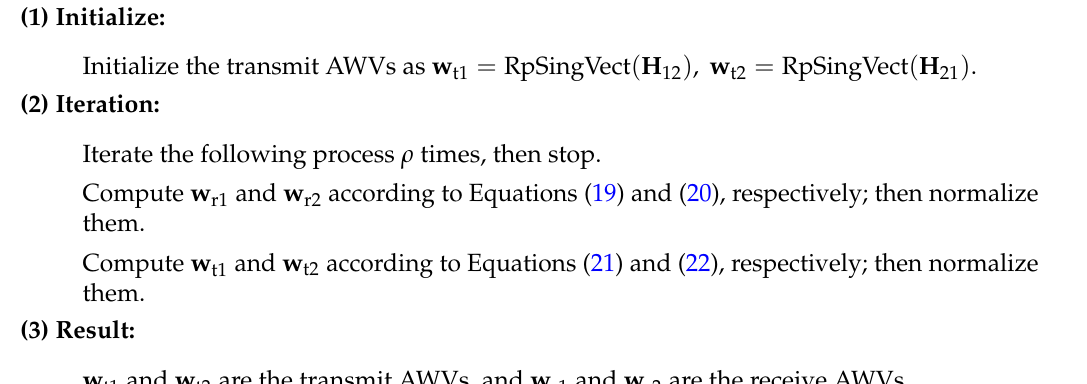
Algorithm 1 The ZF-Max-Power